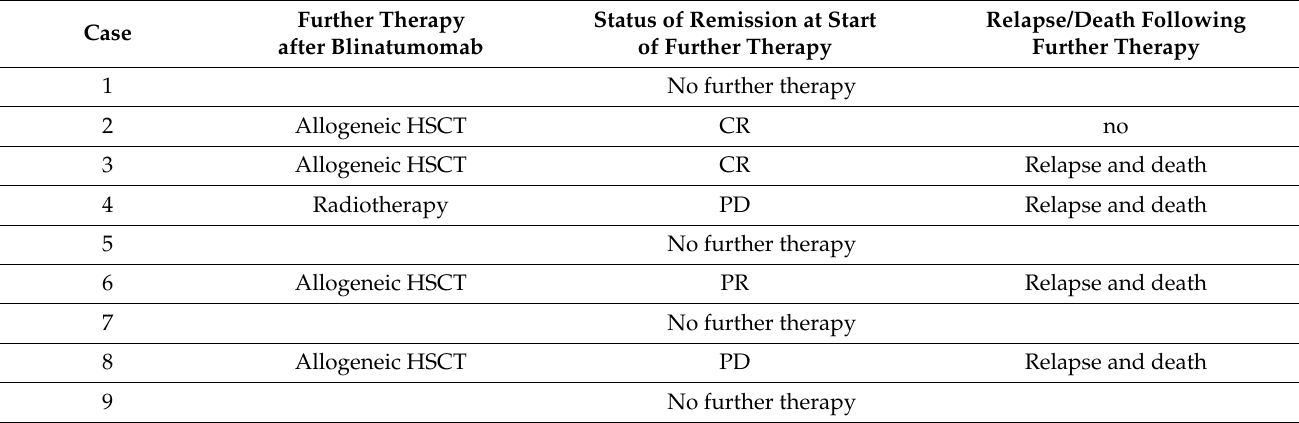
Table 7. Outcomes after blinatumomab